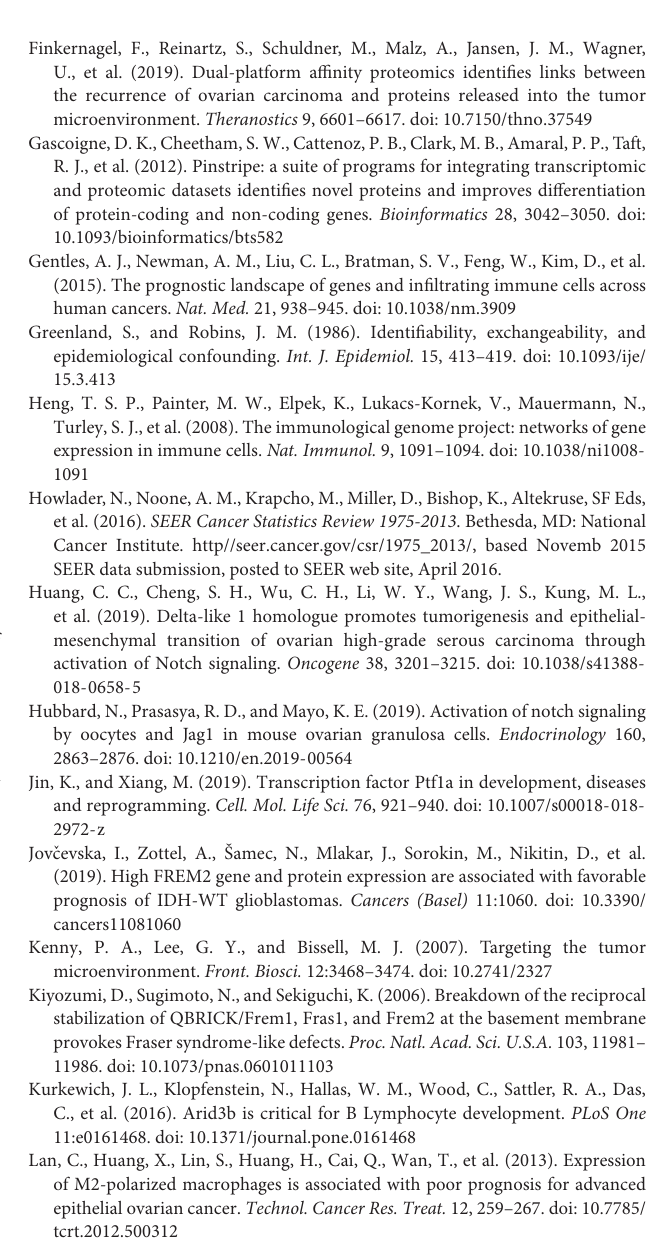
Supplementary Figure 1 | Heat map showing the correlation between 12 candidates gene and 14 confounding variables. The color shade of each color box represented the corresponding Pearson coefficient value between two variables. For each gene, the black point labeled confounding variables were selected confounders. Supplementary Table 1 | Three genes showed significant association after GEO